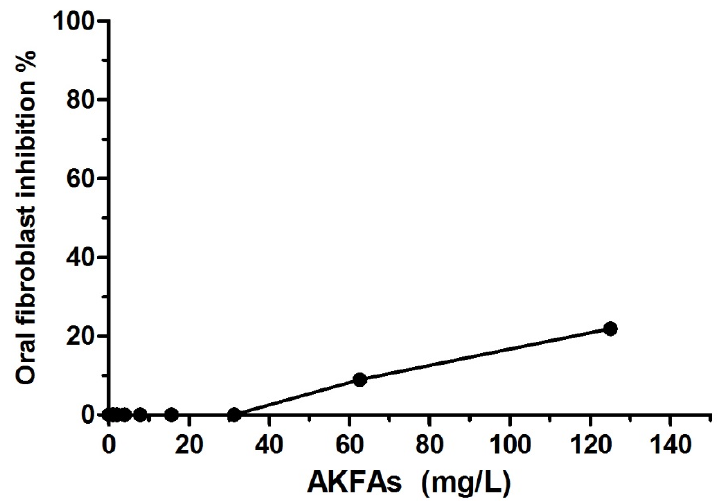
Figure 8. Minimum Cytotoxic effect of the AKFAs on human oral fibroblast cells.